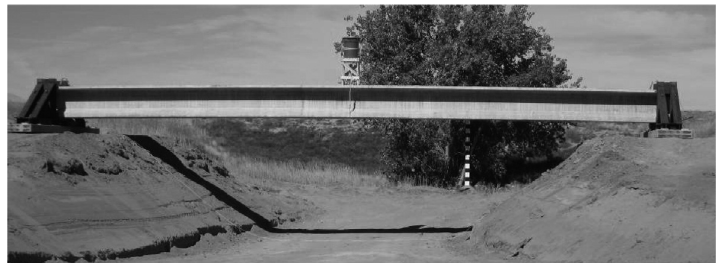
Fig. 6. Test setup (adopted from [13]).